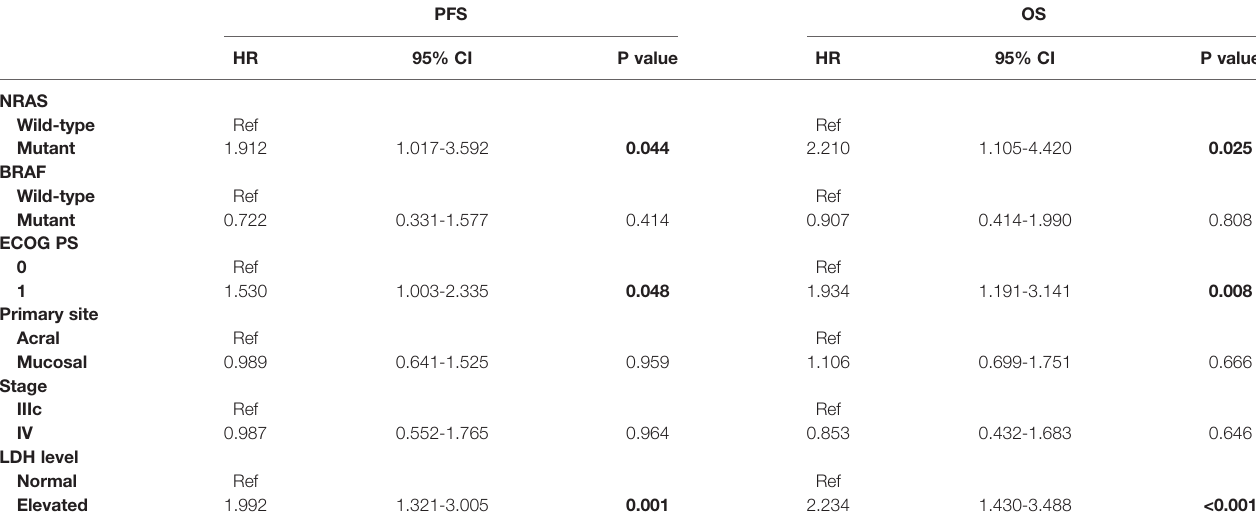
TABLE 4 | Multivariate analysis of factors for PFS and OS in patients with advanced noncutaneous melanoma receiving